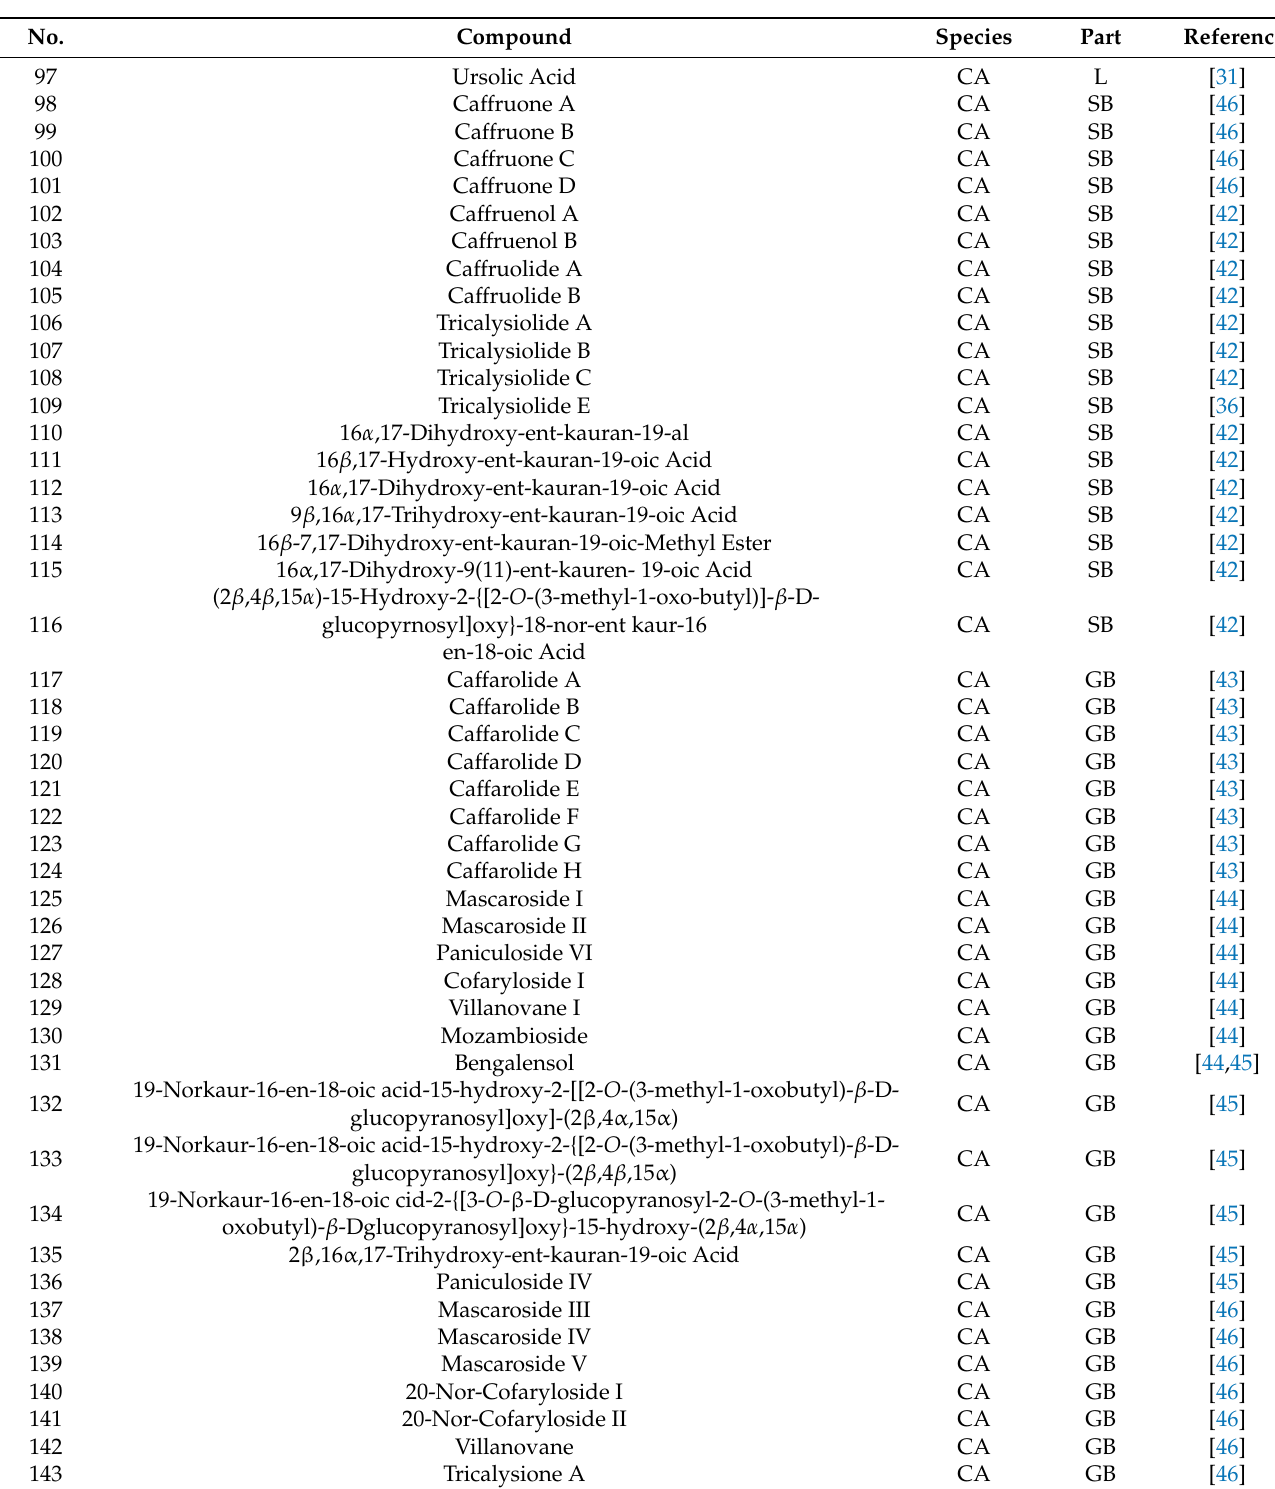
Table 5. Terpenes compounds in